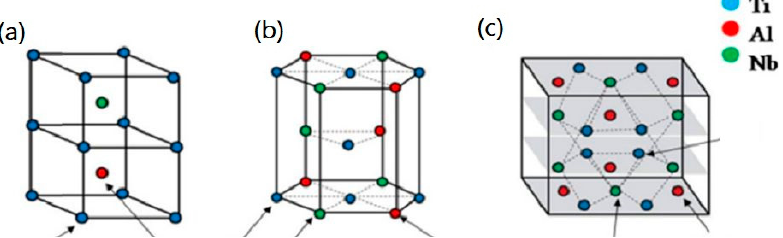
Figure 3. Crystal structures of ( a ) B2, ( b ) α 2 and ( c ) O phase with Wyckoff positions and occupancies. Reproduced with permission from Elsevier [25].